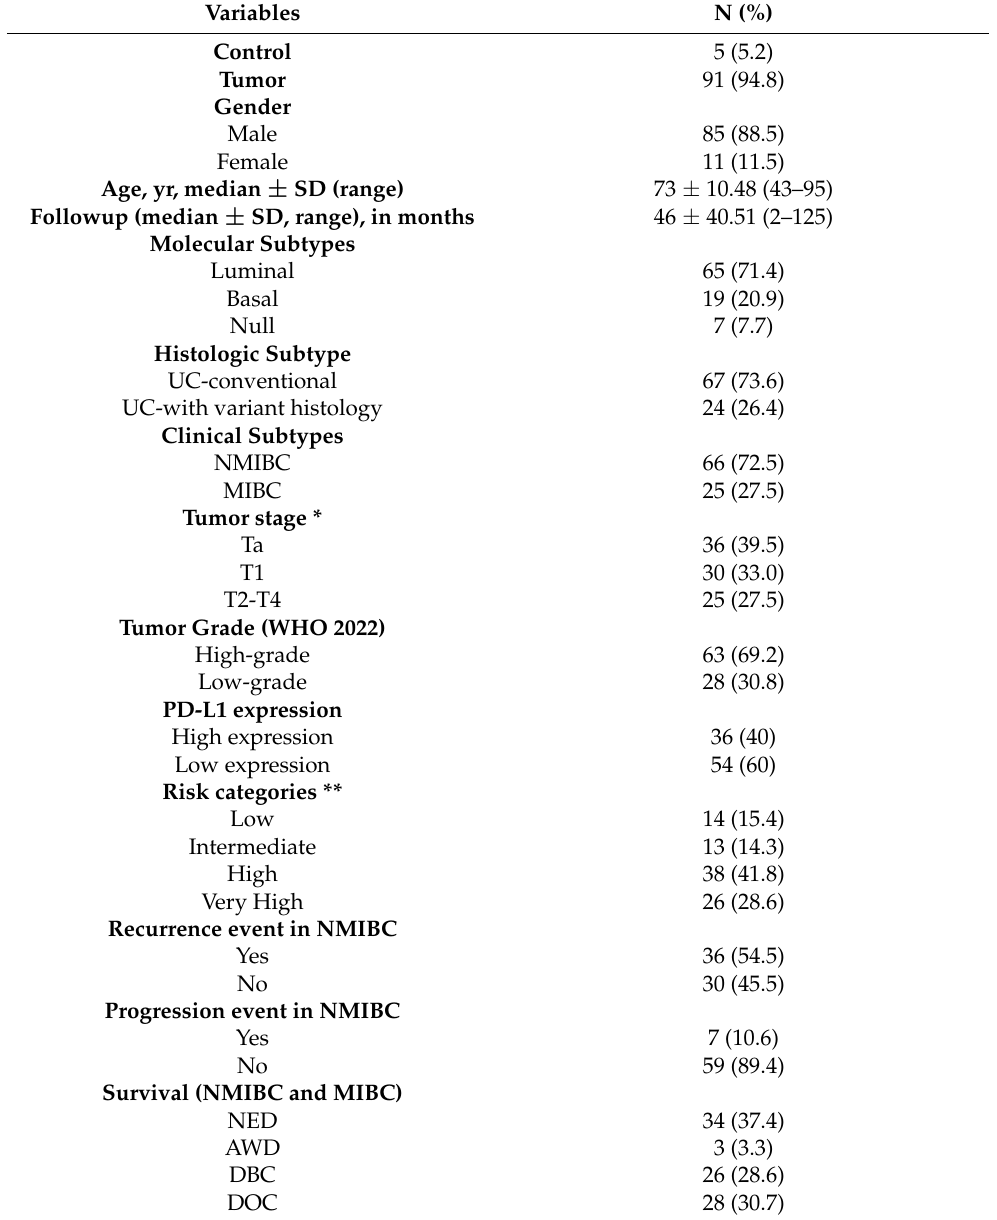
Table 1. Demography and clinicopathological characteristics of patients included in the